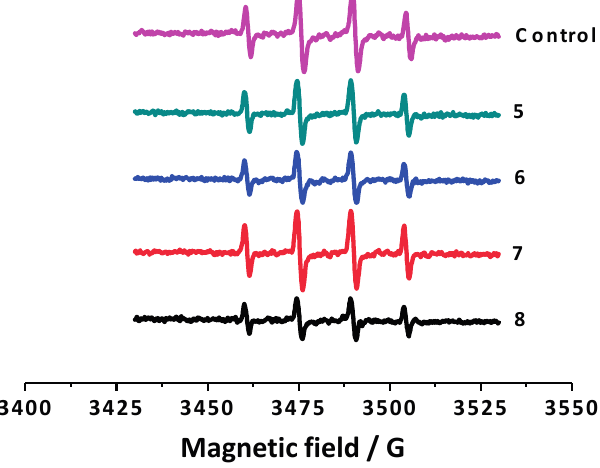
Figure 3. ESR spectra of the control and 3-phenylcoumarins 5 – 8